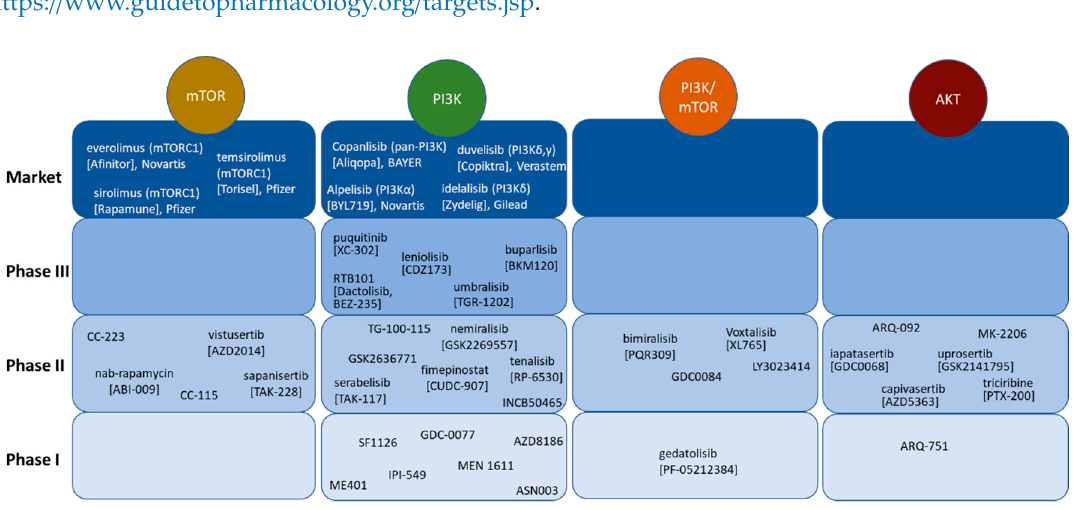
Figure 2. mTOR inhibitors, PI3K inhibitors, dual PI3K / mTOR inhibitors, and AKT inhibitors in clinical development. Drugs are sorted by the stage of their clinical development (Phase I to market) as well as by their mode of action inhibiting AKT, mTOR, PI3K, or PI3K and mTOR. Among PI3K targeting agents, pan-PI3K inhibitors and isoform specific compounds are in clinical development.